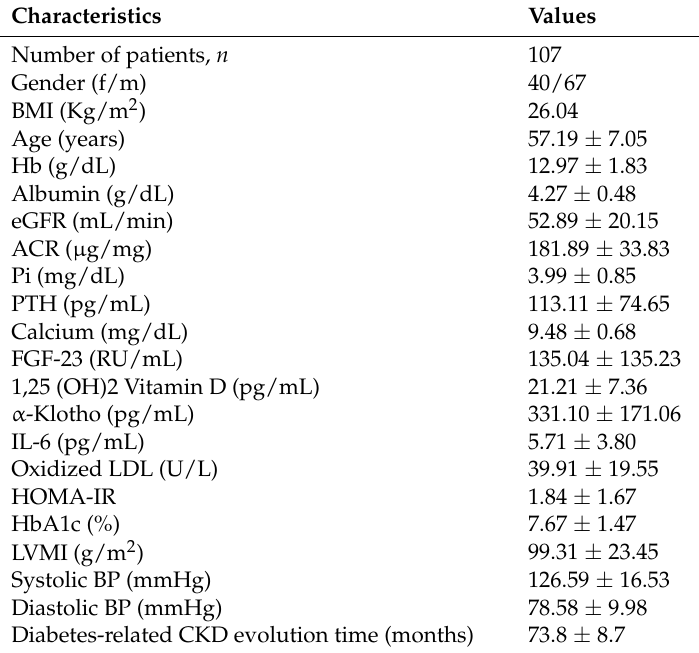
Table 1. Patient demographic and clinical characteristics at